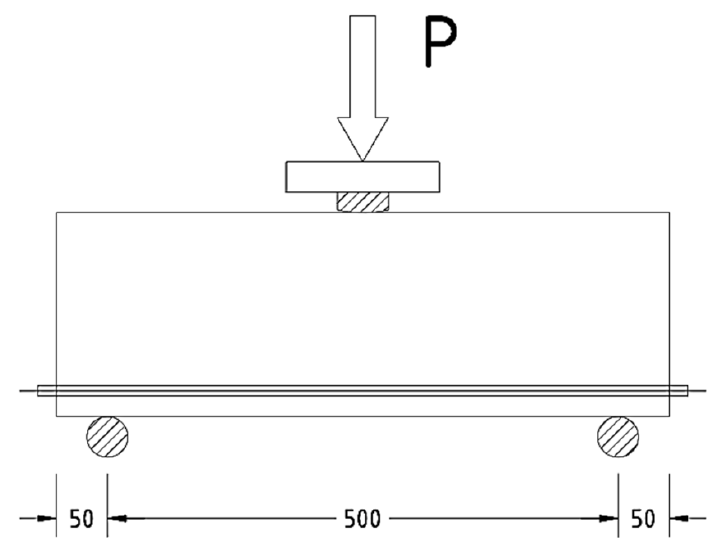
Figure 4. The design scheme of the bending test.